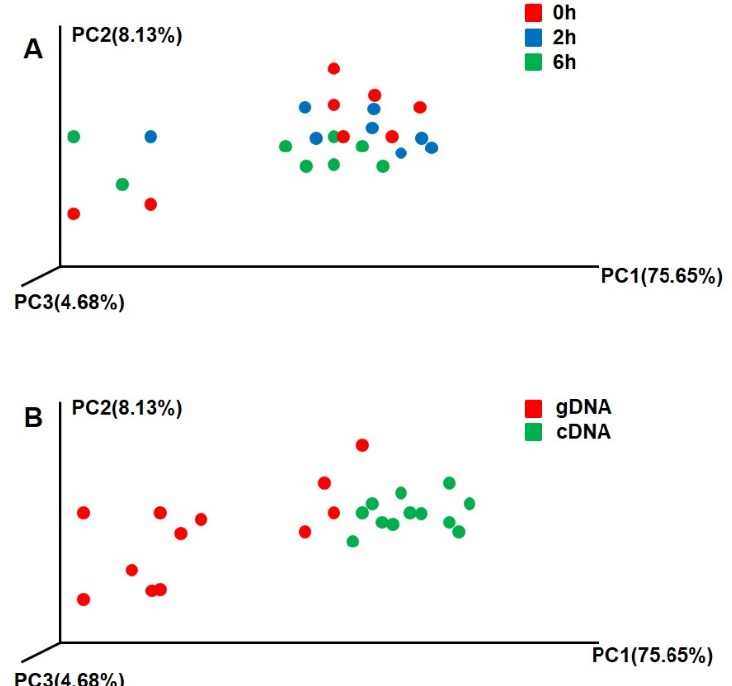
Figure 3. Beta diversity of rumen ureolytic bacteria of gDNA and cDNA. ( A ) Different sampling time, red dot represent 0 h, blue dot represent 2 h, green dot represent 6 h. ( B ) Ureolytic bacteria of gDNA and cDNA, red represent gDNA; green represent cDNA. Principle coordinate analysis (PCA) comparing changes in ureolytic bacteria based on weighted Unifrac distances.